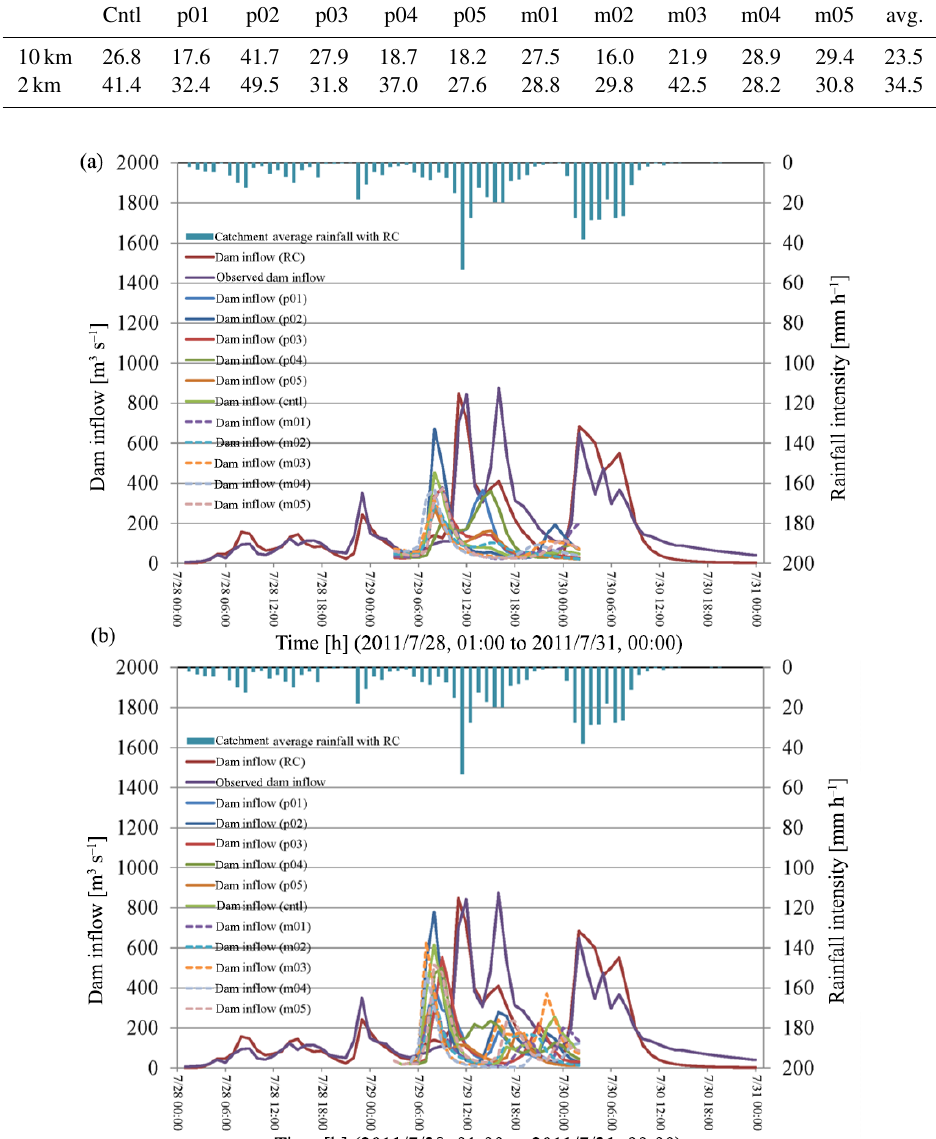
Figure 14. Results of ensemble flood simulations with 10km resolution rainfall (upper) and with 2km resolution rainfall